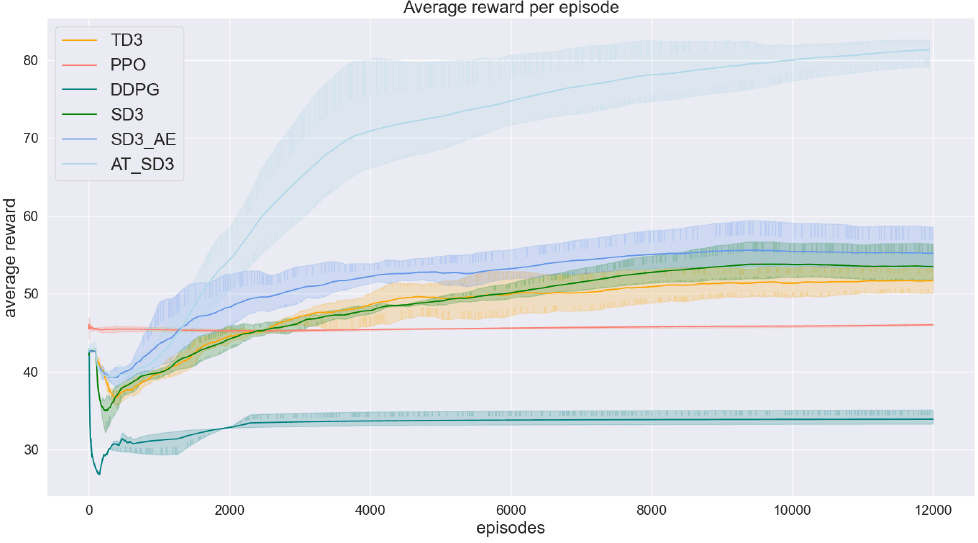
Figure 8. Performance of AT_SD3 and other state-of-the-art DRL